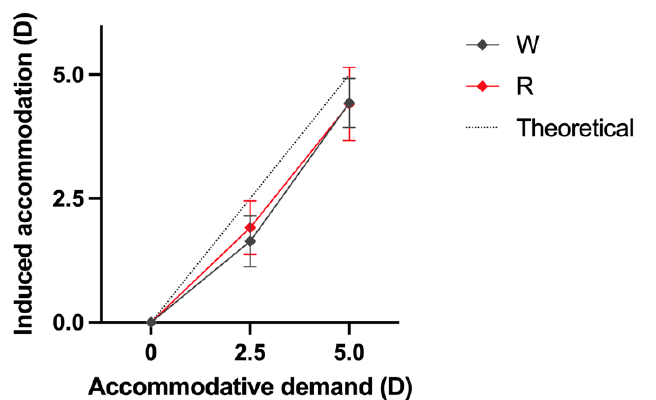
Figure 7. Mean on-axis induced accommodation for each accommodative demand and illumination (R: red light; W: white light; dashed line: theoretical expected values).